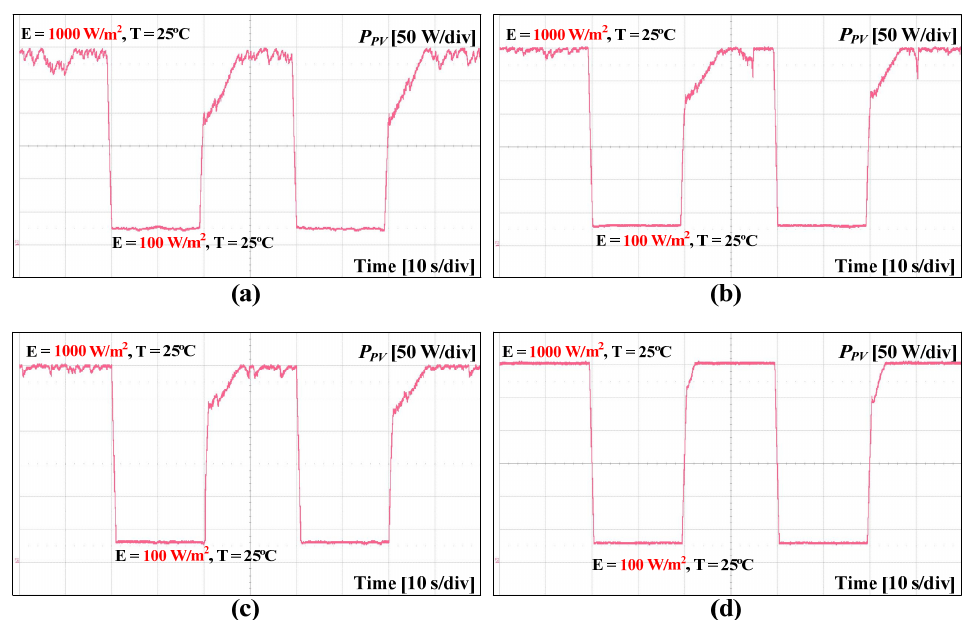
Figure 16. Power ( P PV ) waveforms of the PV module measured using ( a ) the basic P&O algorithm, ( b ) the adaptive P&O algorithm, ( c ) the adaptive INC algorithm, and ( d ) the proposed MPPT algorithm under abruptly changing irradiance conditions.